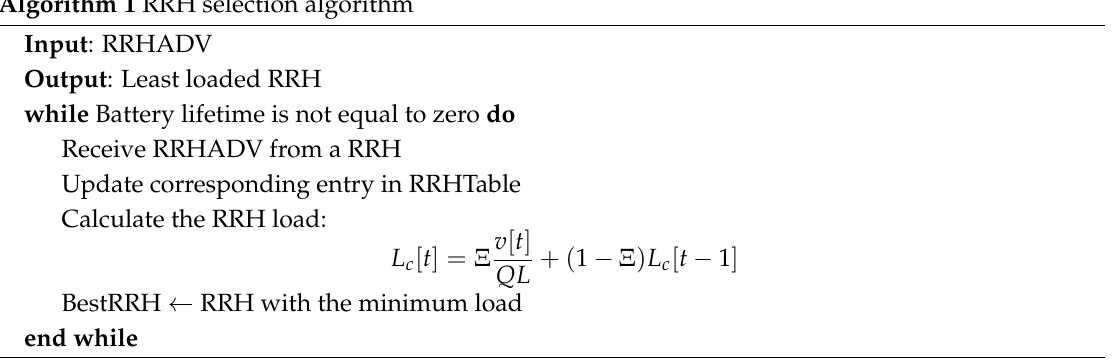
Algorithm 1 RRH selection algorithm